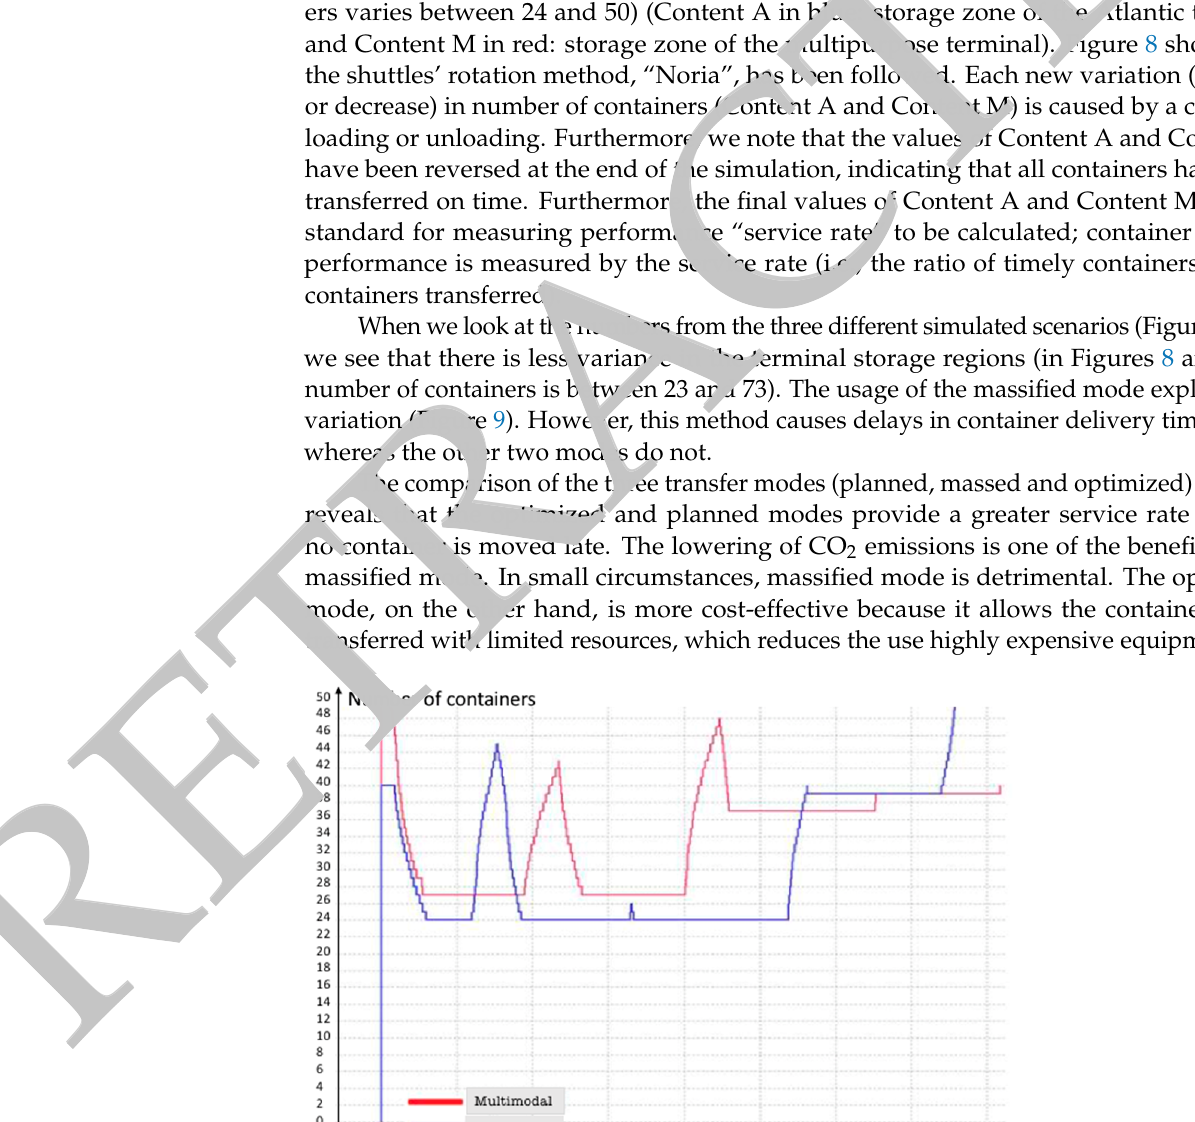
Figure 9. Circulation in mass transfer mode. Figure 10. Circulation in planned transfer mode.